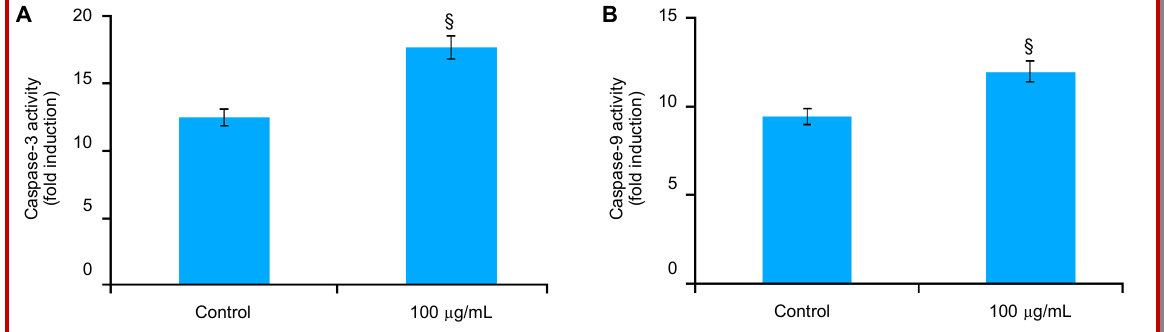
Figure 4: Effect of Z. decandra on the levels of initiator and effector caspases [caspase 3 (A) and caspase 9 (B)] in the conditional medium were evaluated and represented. Results are represented as average values of three independent experiments; § indicates statistical significance (p<0.05). Significance was calculated using one- way ANOVA and student ‘t’ test.